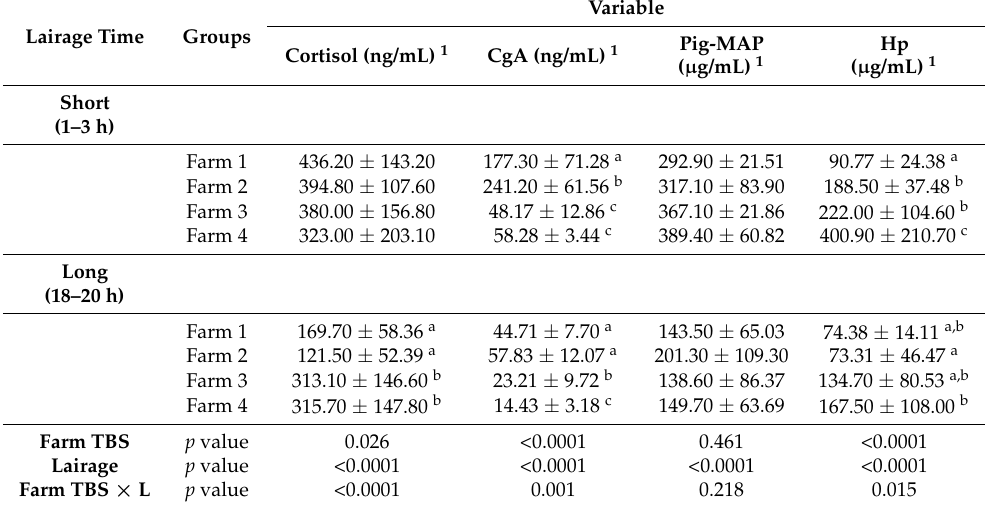
Table 4. Plasma concentrations of stress hormones and acute phase proteins in pigs from four farms with different biosecurity scores at the bleeding point after short and long lairage